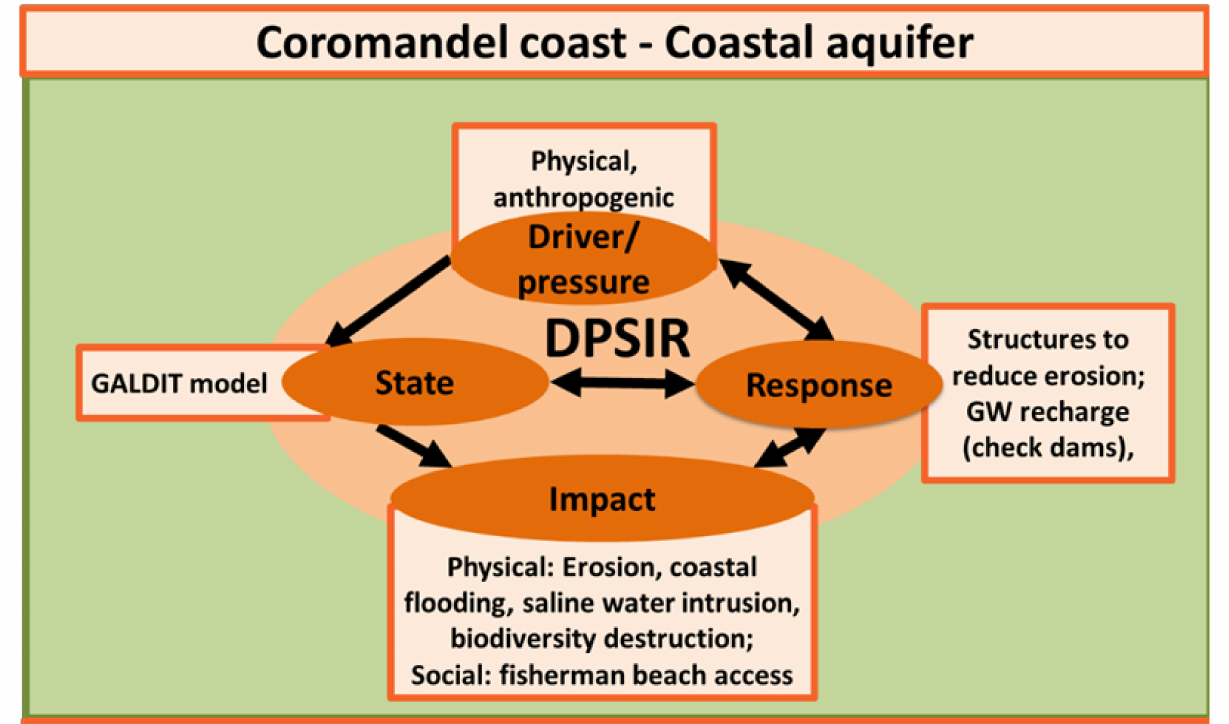
Figure 2. Causal chain/loops developed in framework application for the coastal aquifer,